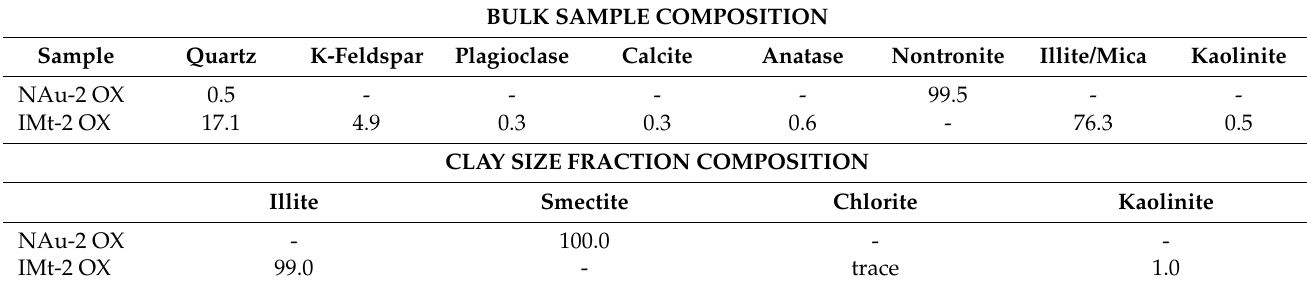
Table 3. Bulk mineralogy and clay size fraction quantitative analysis by X-ray diffraction of the oxidized clay mineral samples NAu-2 and IMt-2.